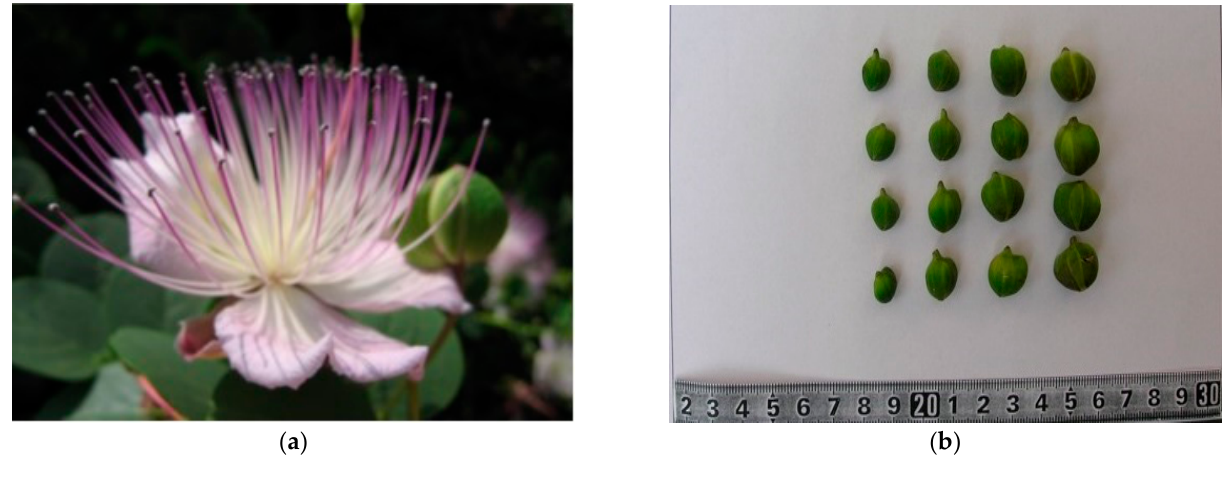
Figure 6. Flower ( a ) and flower buds ( b ) of caper plant.